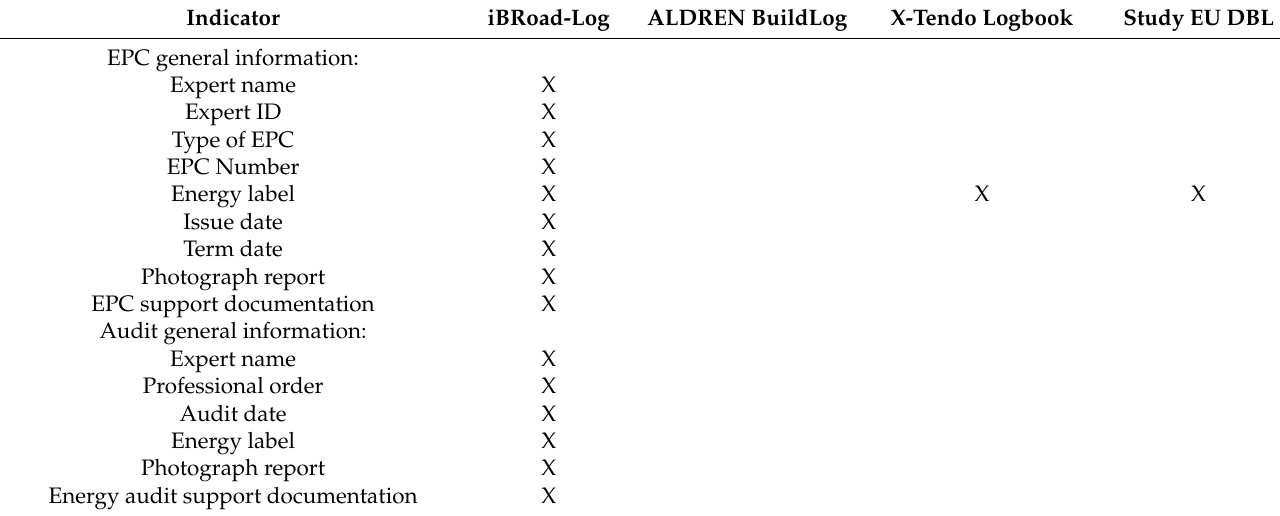
Table A4. Module 4: energy performance, operation and